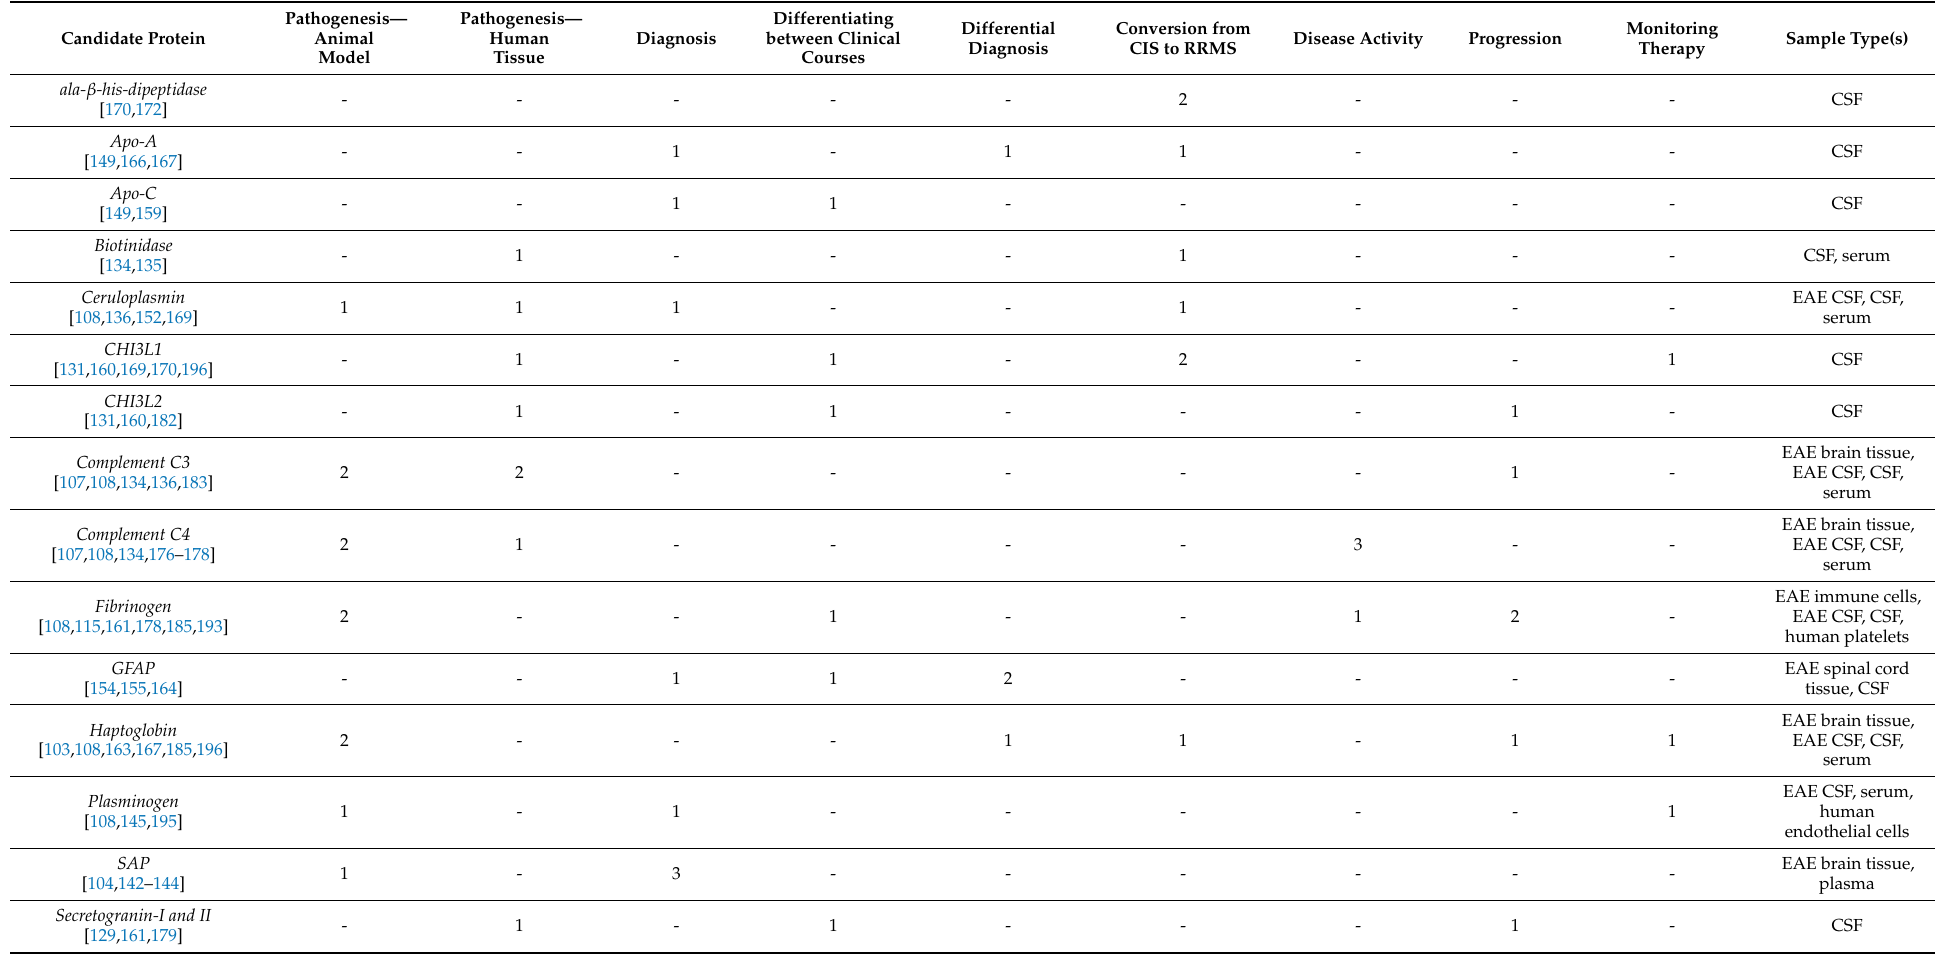
Table 1. Biomarker candidates of the different aspects of multiple sclerosis: peptides with at least two different proteomic studies implying their role in the